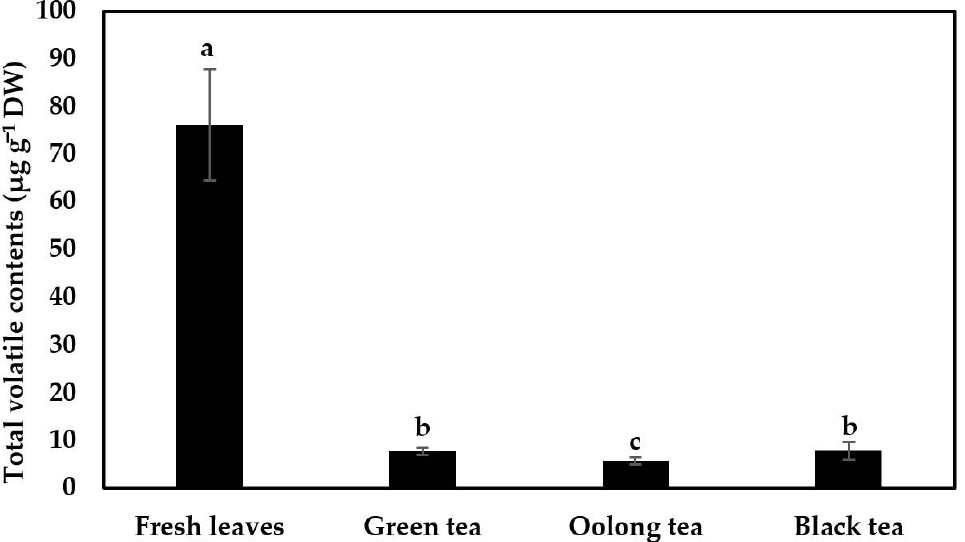
Figure 1. Total volatile contents from fresh leaves, green tea, oolong tea, and black tea. Data are expressed as average ± standard deviation. Different letters indicates statistically significant ( p < 0.05).